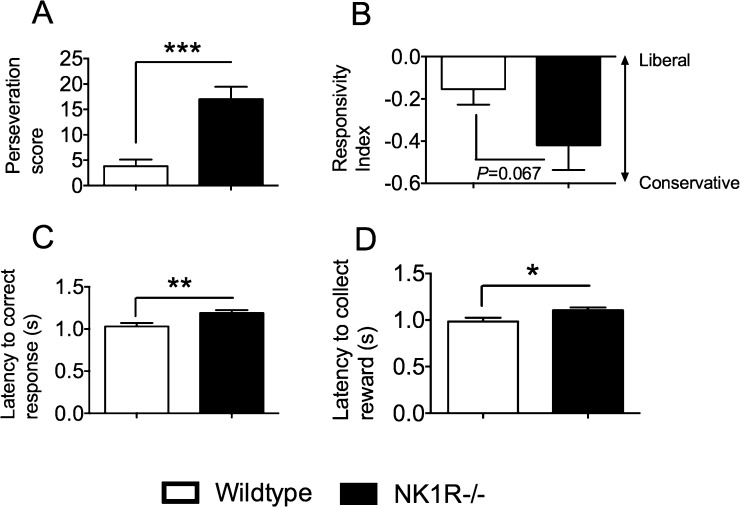
During the extended test session of the 5C-CPT (‘NI-1’), NK1R−/− mice had a higher perseveration score than wildtypes and a longer latency to correct response and latency to collect their reward. Bars show mean ± s.e.m. Lines linking bars indicate statistically significant differences between groups. *P < 0.05, **P < 0.01, ***P < 0.001. N = 12 per group.